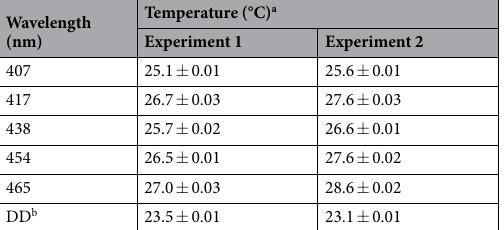
Table 1. Temperatures inside petri dishes irradiated with blue light at 15 × 10 18 photons·m − 2 ·s − 1 in Experiment 1 and 2. a Mean value of the temperatures measured from 12 h to 24 h after the start of irradiation at 5-min intervals using a button-type temperature logger. b DD indicates dark conditions.